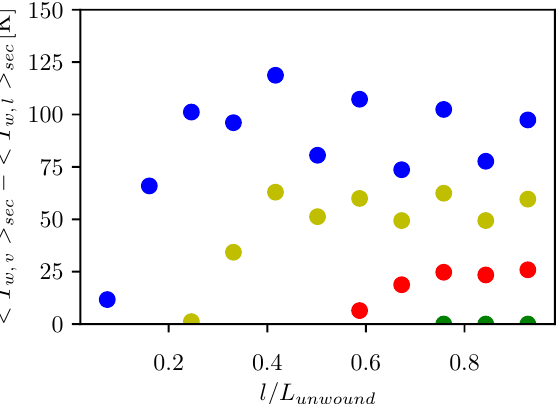
Figure 13. Evolution of the phase-averaged wall temperature difference in the streamwise direction for various cases: case a in red; case c in blue; case d in green; case e in yellow. The use of thermocouples placed at the top and at the bottom of the tube could thus enable identification of the flow regime inside a section of the tube.